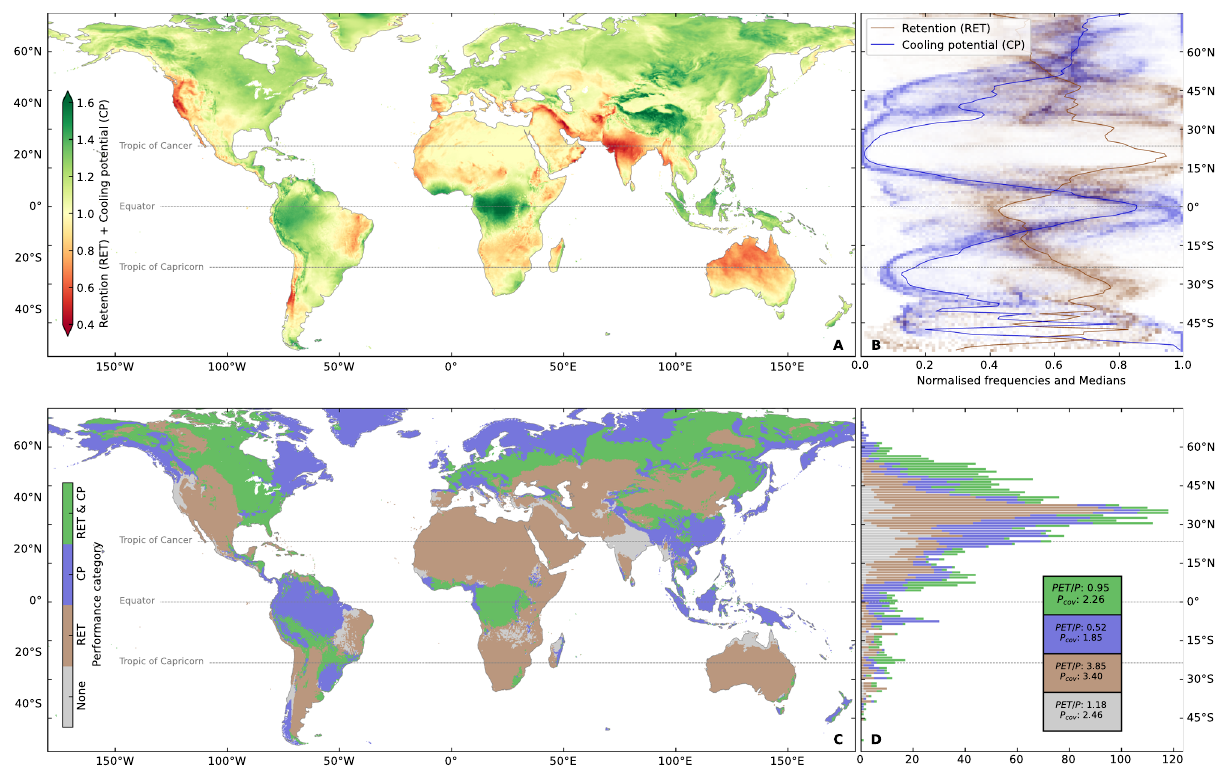
Fig. 2 Global trade-offs between mean retention and cooling potential. ( A ) Global map of the sum of mean retention and cooling potential metrics. ( B ) Latitudinal summaries of mean retention and cooling potential. Shading maps the binned frequencies normalized for 1° latitude bands. Solid lines are medians across the latitudes. ( C ) Categorized performance of mean retention only >0.5 (RET), mean cooling potential only >0.5 (CP), mean retention and mean cooling potential both >0.5 (RET & CP), or neither mean retention or mean cooling potential >0.5 (None). ( D ) Latitudinal summaries by categories de fi ned in ( C ) for large cities (de fi ned as having population > 100,000 in the year 2000 CE). Inset indicates the median value of PET/P and coef fi cient of variation in daily precipitation (Pcov) for each mapped category. All results shown are for intensive substrates ( h = 150 mm) — equivalent results for other substrates are given in Supplementary Figs. 10 and 11.